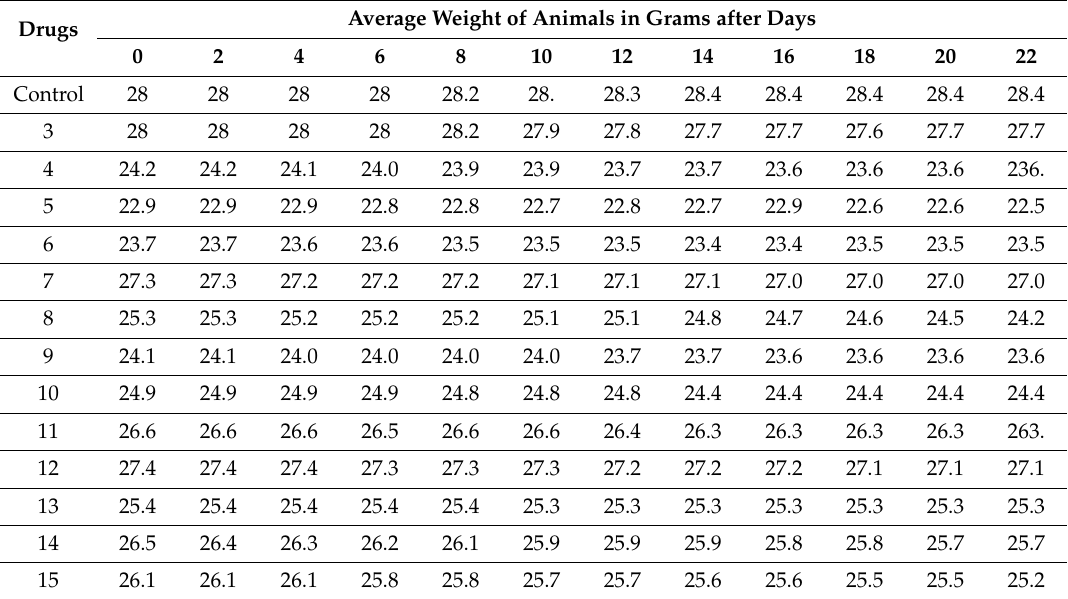
Table 1. The average weight of each group of mice treated with drug and the control group. Drugs